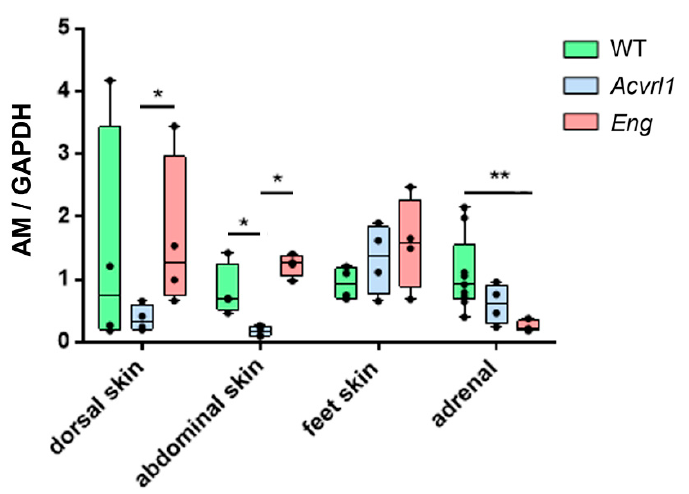
Figure 6. AM expression in some ectoderm-derived organs as measured by qRT-PCR. Box plots represent the interquartile range with the median as a horizontal line. Whiskers encompass the maximum and minimum values of the population. Dots represent individual animals. *: p < 0.05; **: p < 0.01.